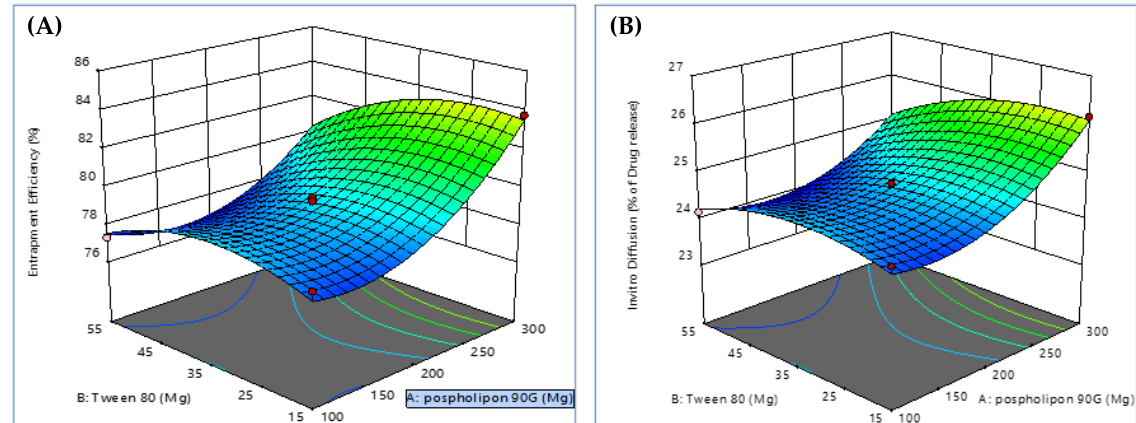
various responses. The interactions’ quadratic nature was confirmed by the higher values of the standard error for the coefficient.